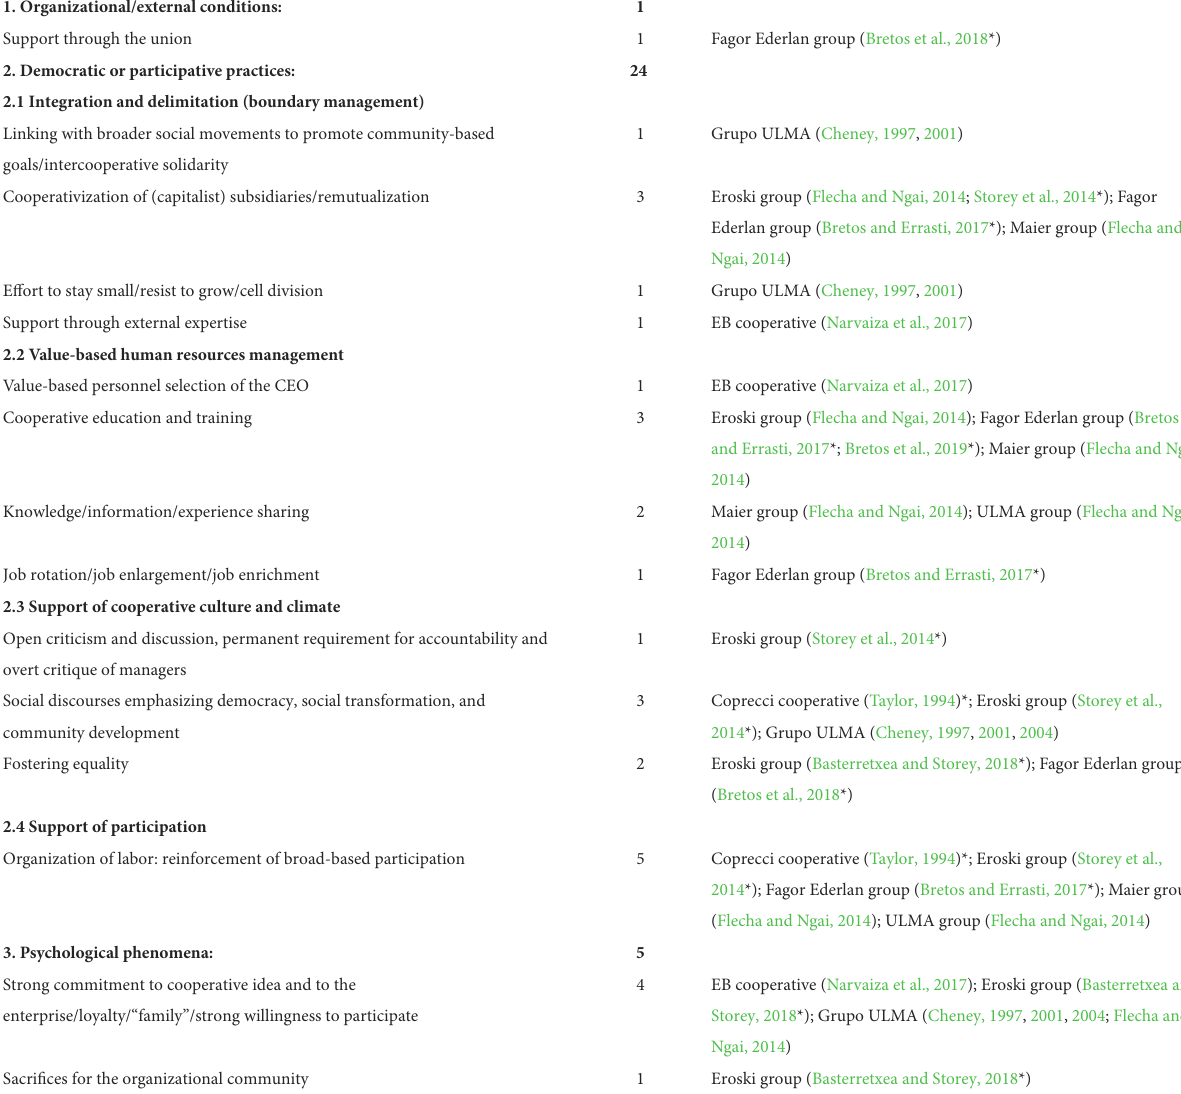
TABLE 8 Frequencies of conditions, practices, and psychological phenomena of all forms of retention or regeneration mentioned ( n = 6 cases) of the Mondragon Cooperative Corporation. Conditions, practices, and psychological